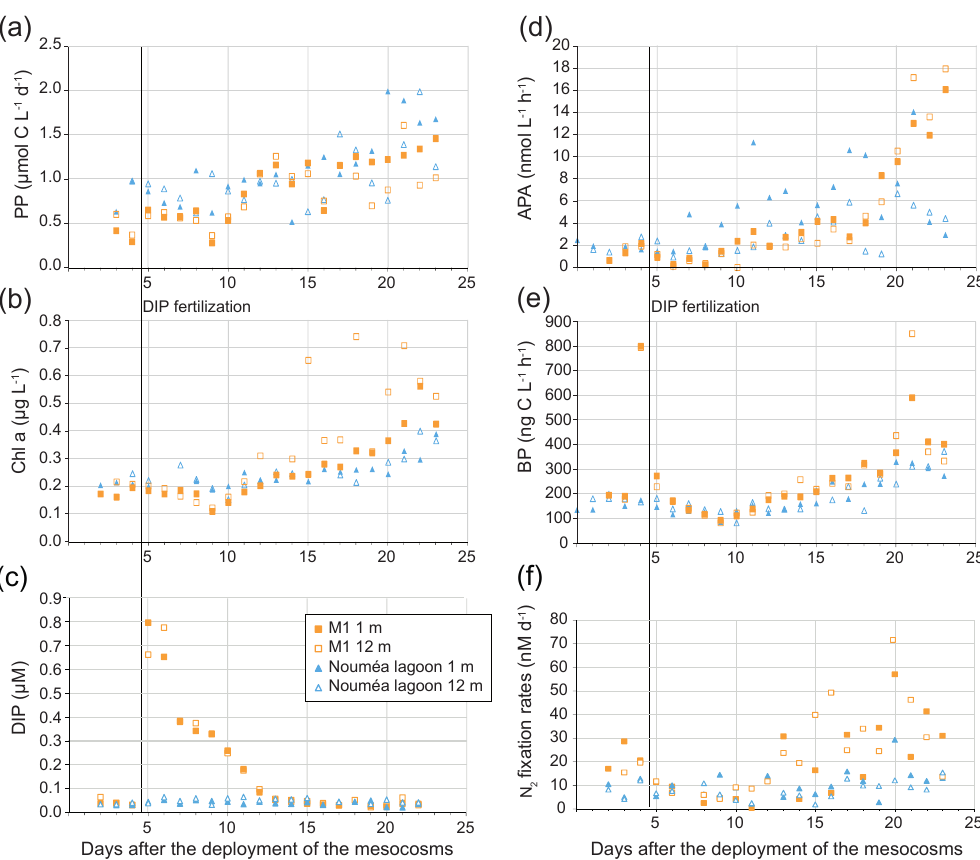
Figure 1. Evolution of selected parameters in mesocosm M1 and the Nouméa lagoon at depths of 1 and 12m. (a) Primary production (PP), (b) chlorophyll a (Chl a) concentration, (c) dissolved inorganic phosphorous (DIP), (d) alkaline phosphatase activity (APA), (e) heterotrophic bacterial production (BP, measured by 3H-leucine assimilation), and (f) N 2 -fixation rates as measured by 15 N incorporation in M1 and the Nouméa